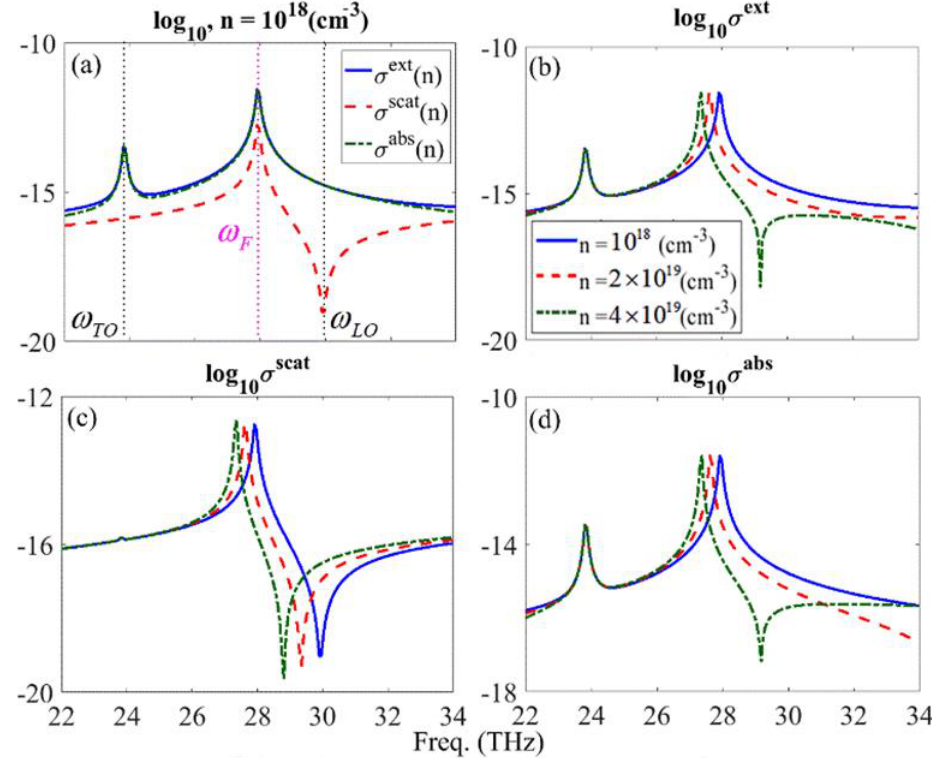
Figure 3. ( a ) The logarithmic carrier concentration dependency of the extinction (solid-curve), scattering (dashed curve) and absorption (dashed-dotted curve) spectrum, respectively, of a 4H-SiC nano-sphere and for n = 10 18 cm − 3 . ( b – d ) The logarithmic scale of the extinction, scattering and absorption spectrums for n = 10 18 (solid curve), n = 2 × 10 19 (dashed curve), n = 4 × 10 19 (dashed dotted curve), respectively.